Question: Write a single sentence explaining what this figure depicts.
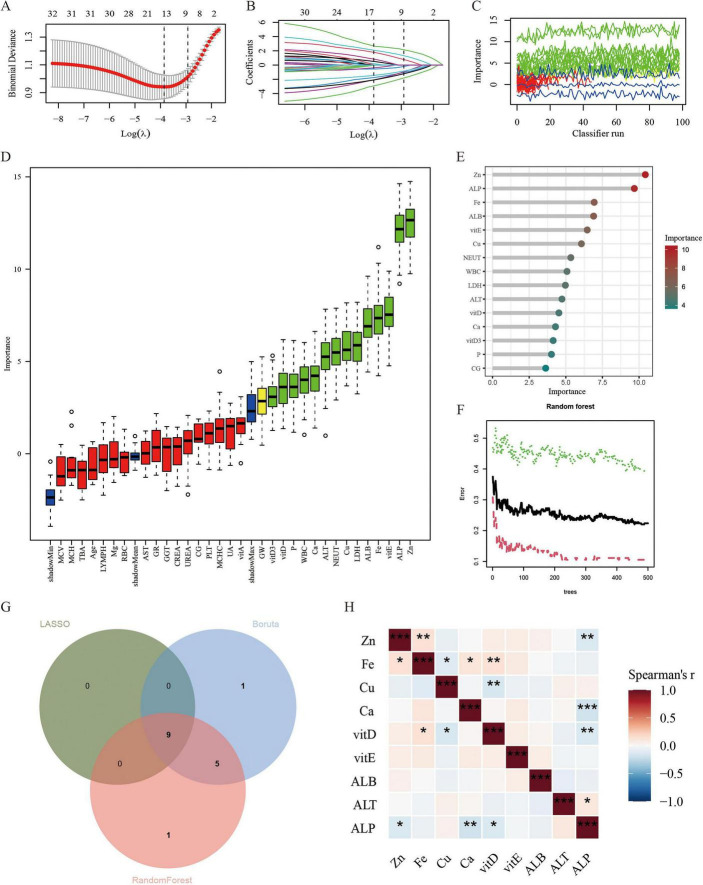
Answer: Variable selection and correlation analysis. (A) Ten-fold cross-validation curve of LASSO regression for determining the optimal penalty parameter λ. (B) LASSO coefficient path plot showing coefficient shrinkage across different λ values. (C) Variable importance trajectories across classifier runs in the Boruta algorithm. (D) Distribution and ranking of variable importance identified by the Boruta algorithm. (E) Variable importance ranking based on the random forest model. (F) Changes in random forest model error with increasing numbers of trees. (G) Venn diagram of variables selected by LASSO, Boruta, and random forest. (H) Spearman correlation heatmap of the final selected variables. * P < 0.05, ** P < 0.01, and *** P < 0.001.